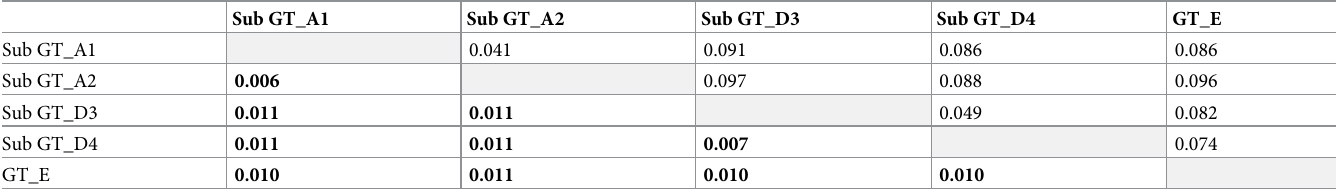
Table 1. Divergence between HBV genotypes/subgenotypes present in Portugal.